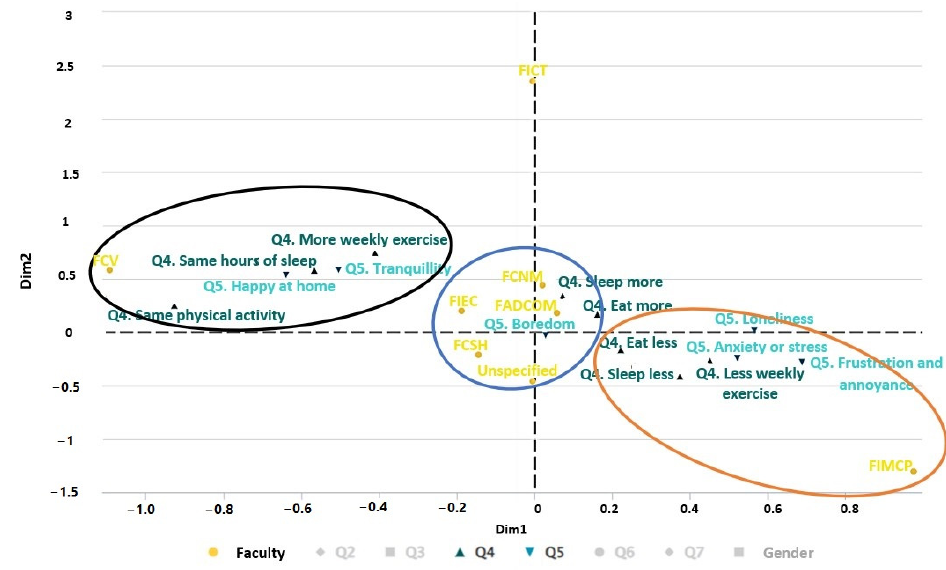
Figure 6 . Multiple correspondence analysis (MCA) of the variables of faculty, Q4, and Q5.